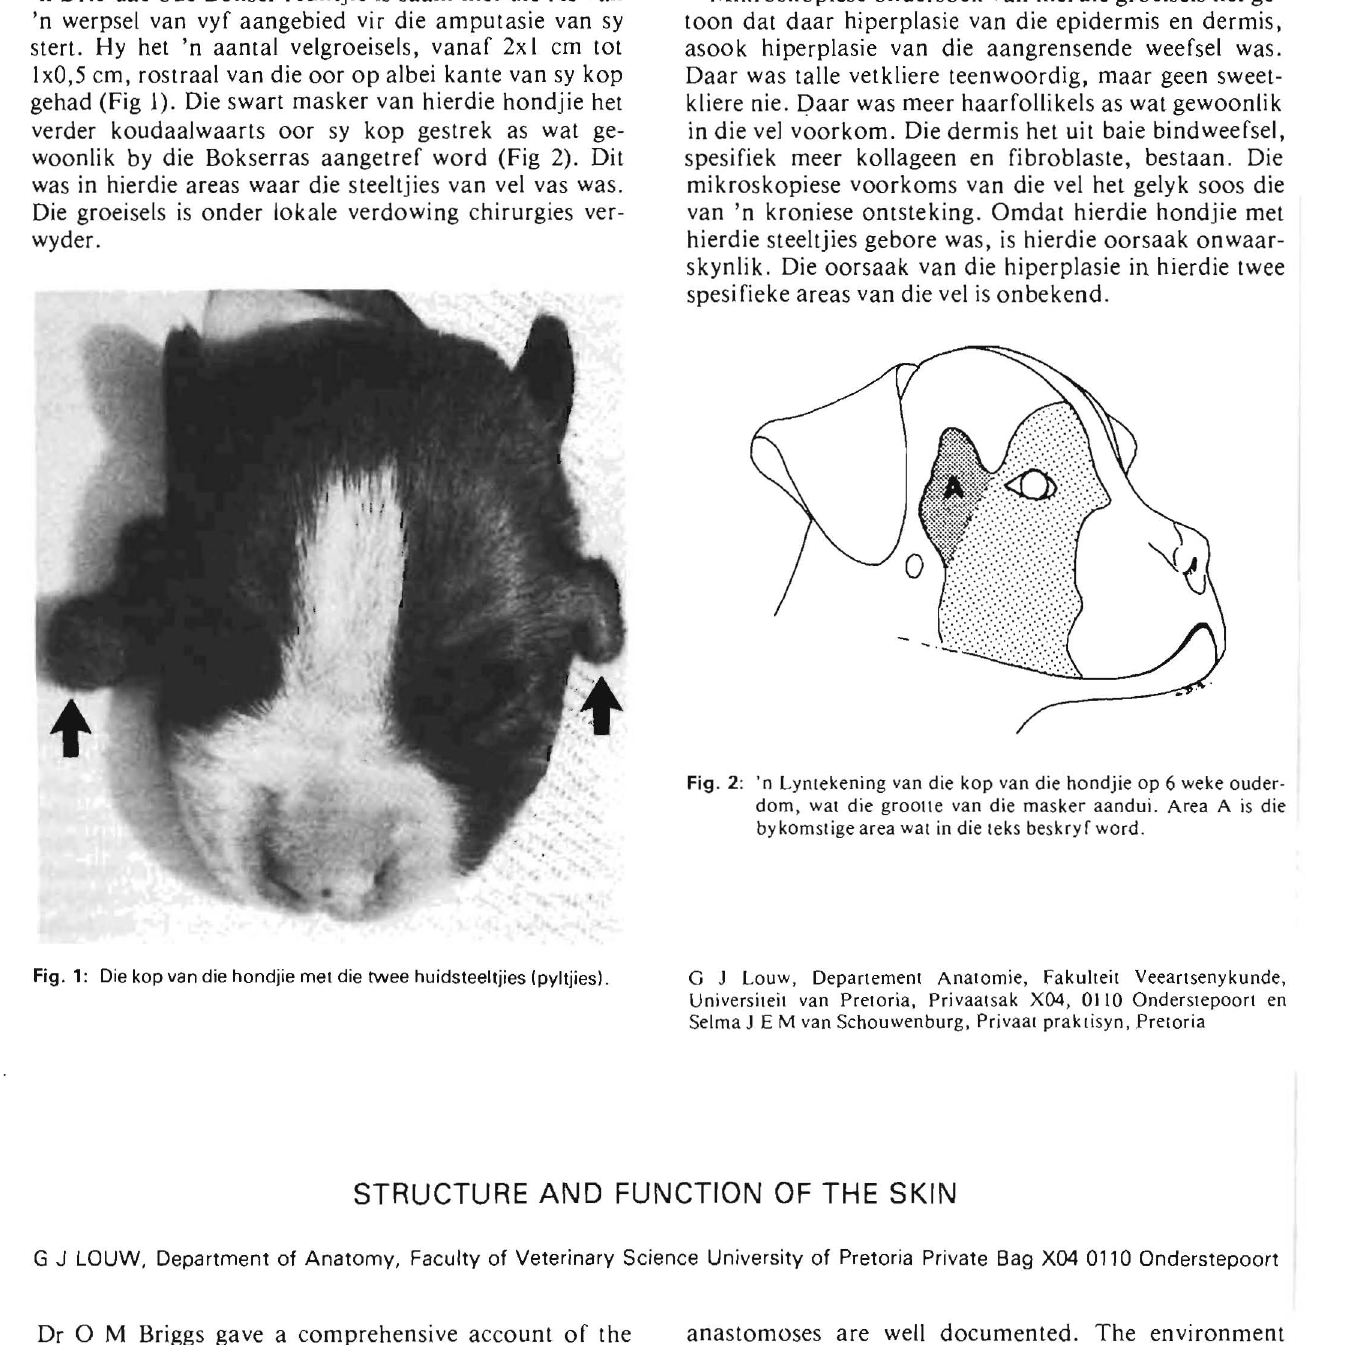
Mikroskopiese ondersoek van hierdie groeisels het ge